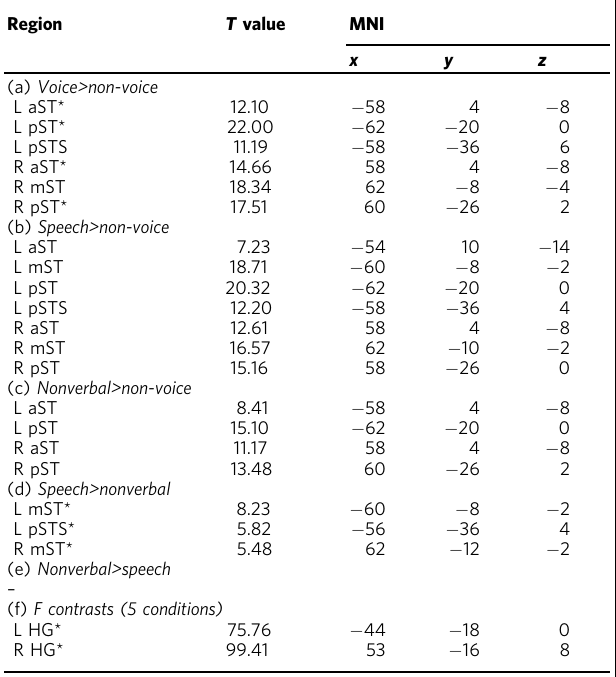
Table 1 Neuronal peak activations.